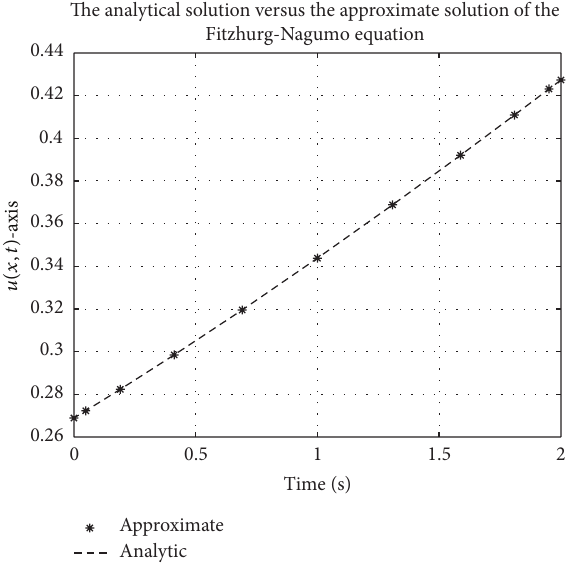
Figure 5: Modified KdV-Burger equation analytical solution graph.